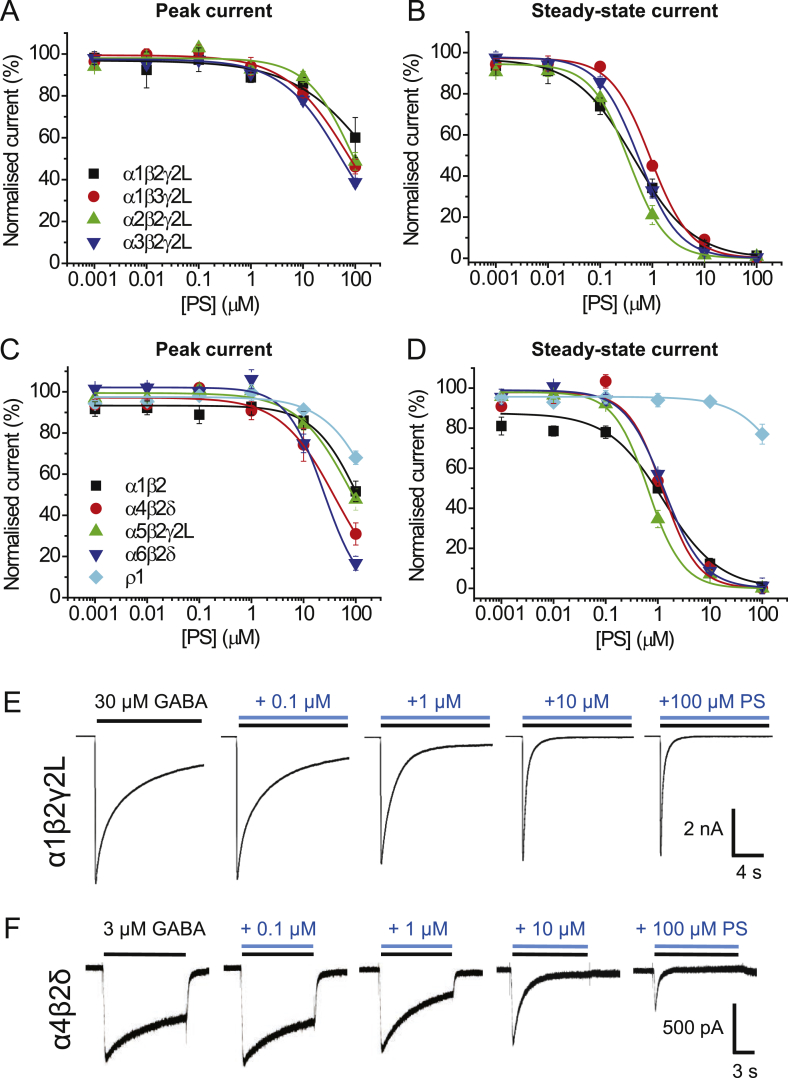
Inhibition of GABA currents by PS at different GABAA receptor subtypes.(A, B) Inhibition of GABA EC80 peak (A) and steady-state (B) currents by PS at synaptic-type receptors, including: α1β2γ2L (black), α1β3γ2L (red), α2β2γ2L (green) and α3β2γ2L (blue) (n = 5–7). (C,D) Inhibition of GABA EC80 peak (C) and steady-state (D) currents by PS at extrasynaptic-type GABAARs, including α1β2 (black), α4β2δ (red), α5β2γ2L (green), α6β2δ (blue) and ρ1 (cyan) (n = 5–6). Data points represent mean ± SEM. Curves were fitted as described in the Methods. (E,F) GABA EC80 responses and the effect of co-applications with 0.1–100 μM PS at α1β2γ2L, a typical synaptic-type receptor (E), and α4β2δ, a typical extrasynaptic-type receptor (F). (For interpretation of the references to colour in this figure legend, the reader is referred to the Web version of this article.)